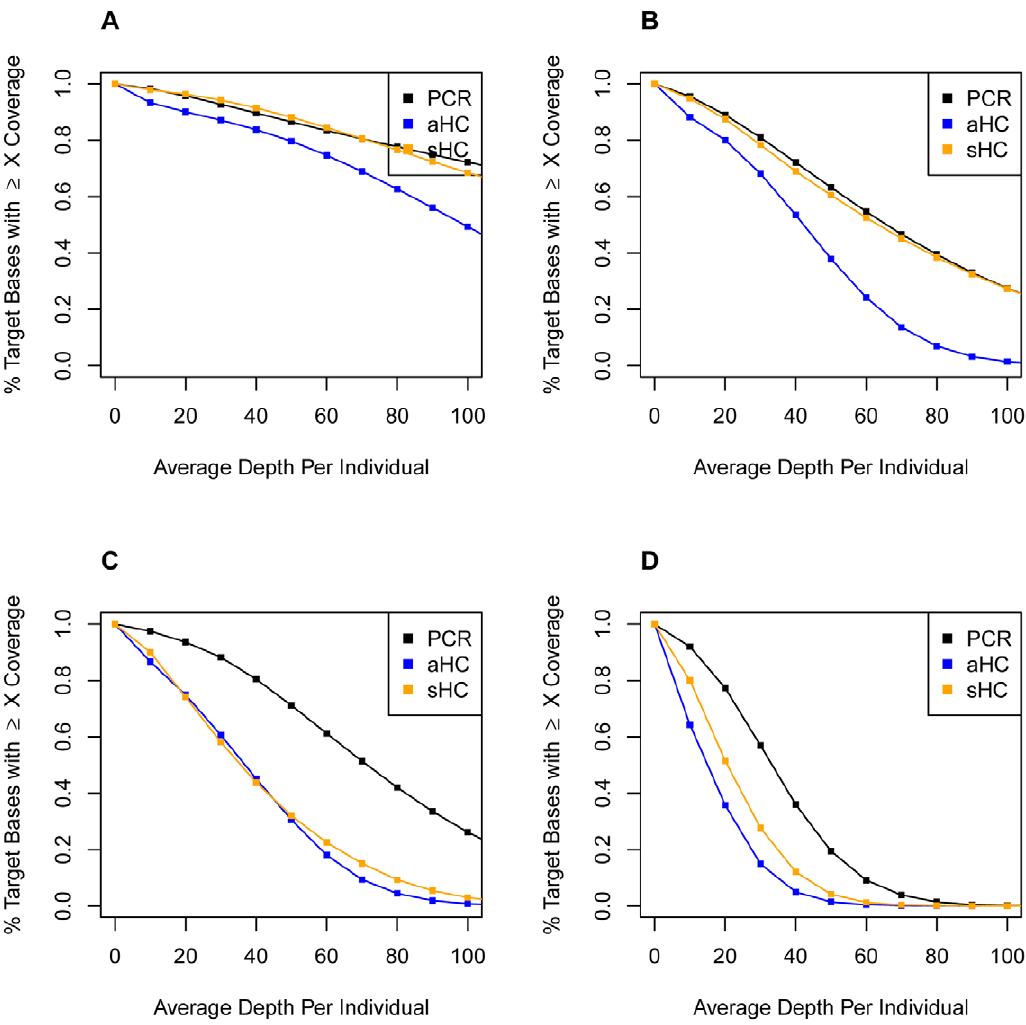
Figure 1. Target coverage per individual in pool before duplicate removal. This shows a cumulative relative frequency plot of the percentage of target bases with § X coverage depth normalized by the number of individuals sequenced for: (A) Pool of 2, (B) Pool of 10, (C) Pool of 20 and (D) Pool of 50 individuals. The x-axis is in increments of 10 6 coverage. The black squares/lines illustrate the data for PCR enrichment, the blue squares/lines illustrate the data for aHC enrichment and the orange squares/lines illustrate the data for sHC enrichment. The first square represents the percentage of target bases with § 10 6 coverage per individual in the pool, and so on for each square in increments of 10 6 . This analysis assumes equal representation of each individual in the pool of